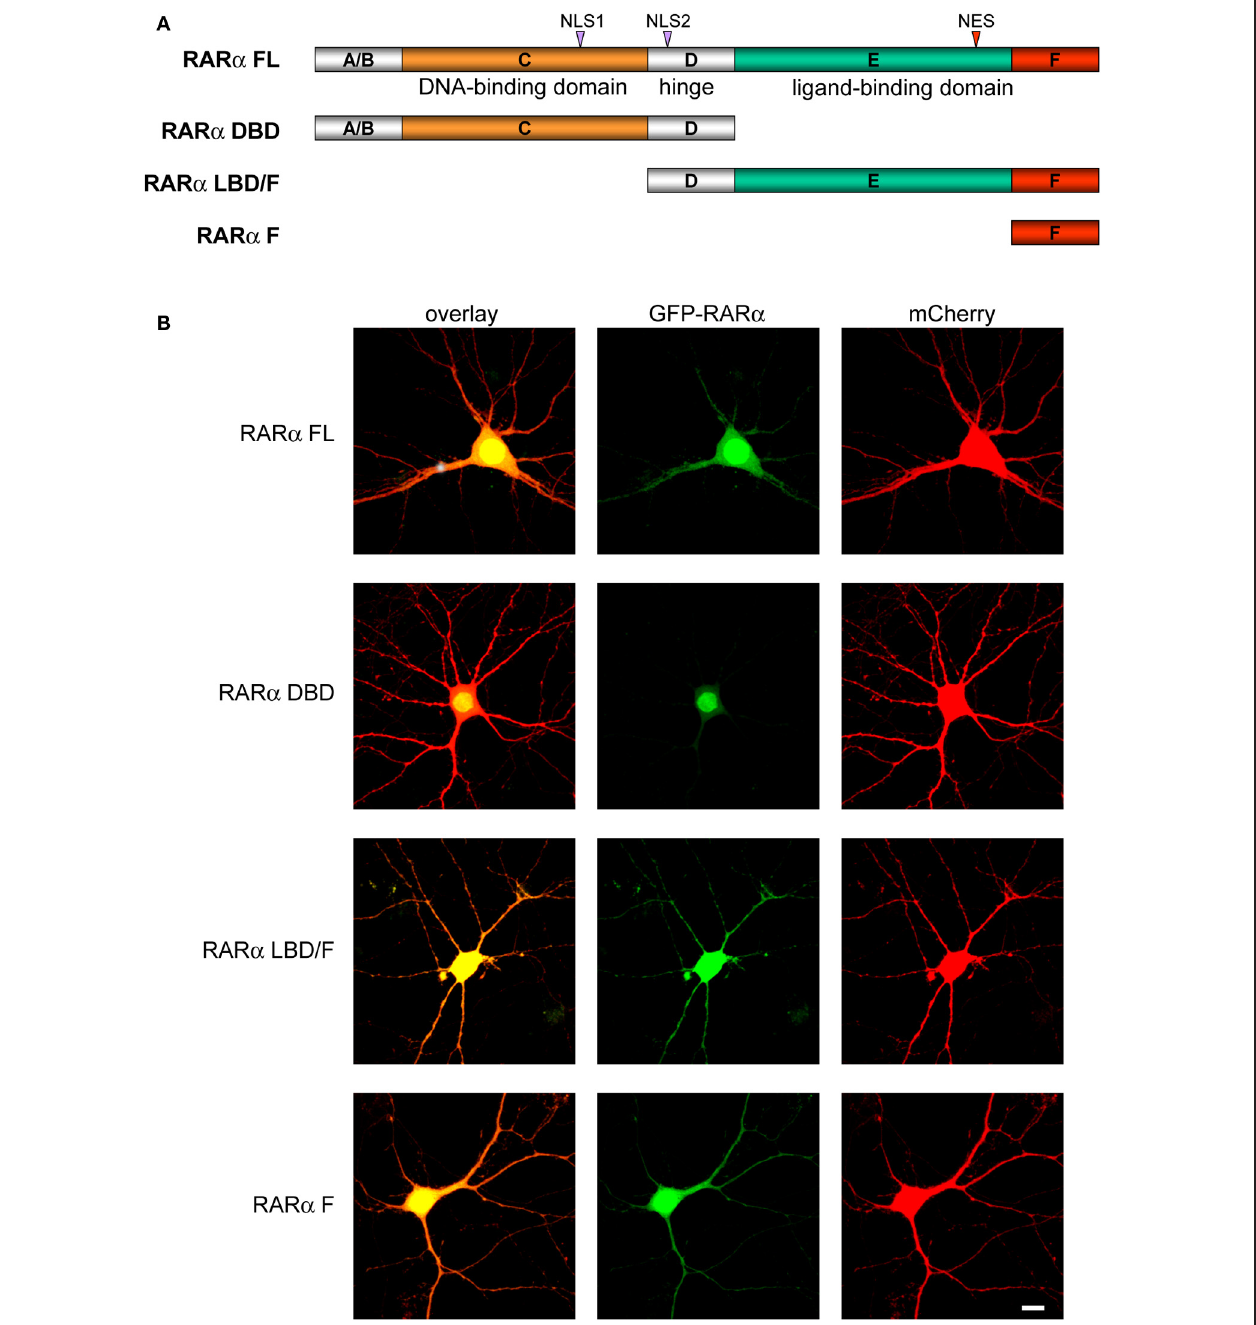
FIGURE 3 | Subcellular localization of RAR α and its deletion mutants. (A) Schematic of RAR α deletion constructs. Recombinant full-length and truncated RAR α domains were encoded as N-Terminal eGFP fusion proteins (FL, Full-length; DBD, N-terminal DNA Binding Domain; LBD; F, C-Terminal